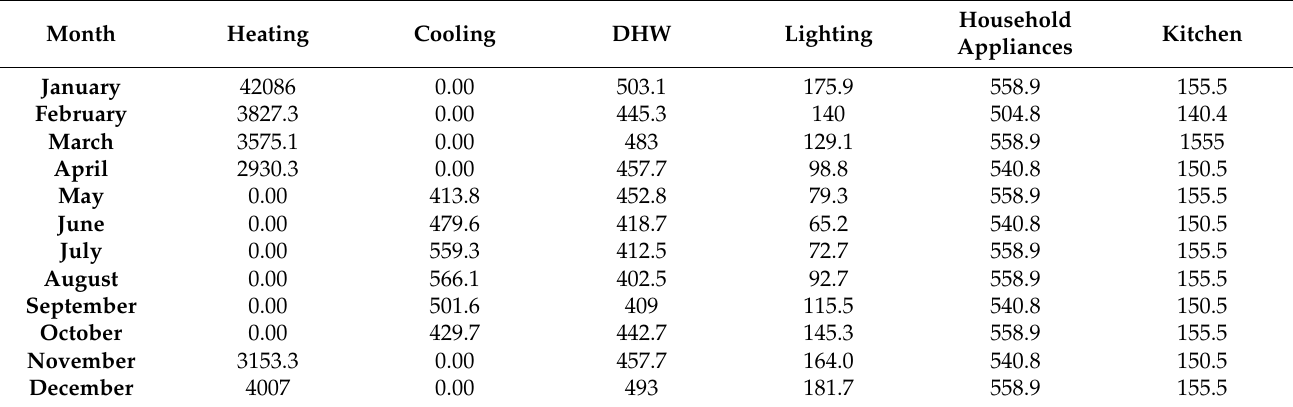
Table 5. Monthly energy demands calculated from annual energy demands